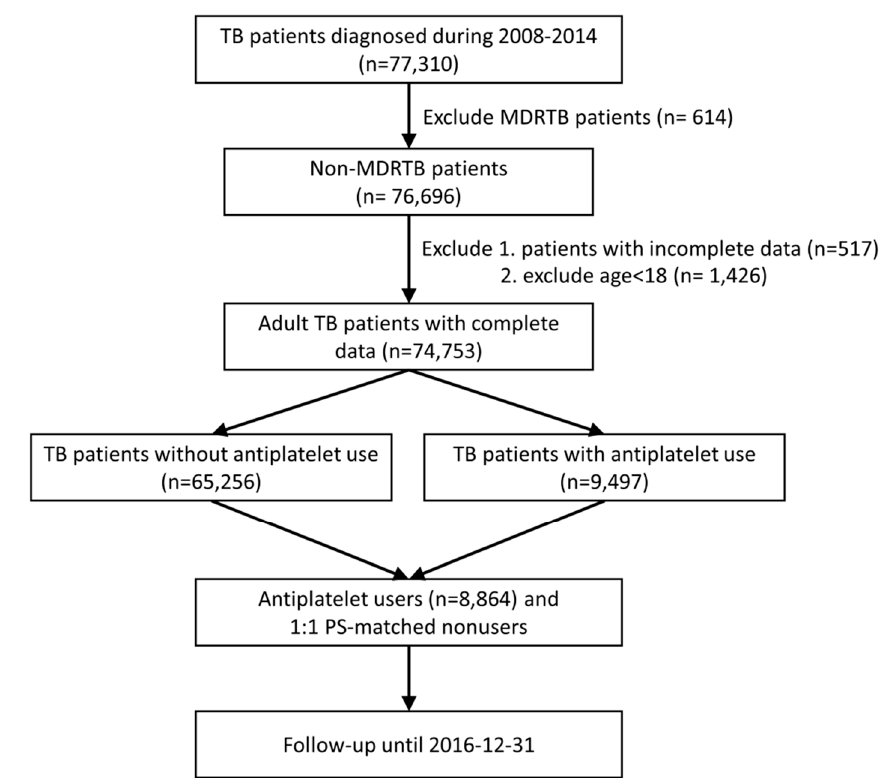
Figure 1. Flowchart of patient recruitment.